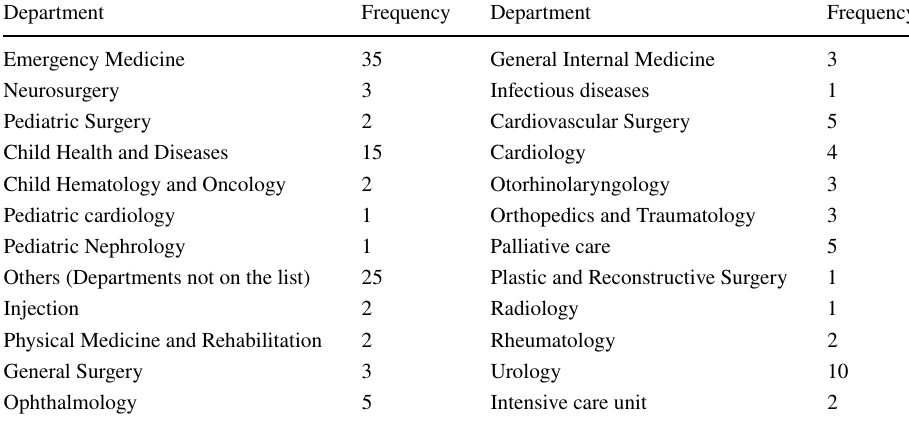
the departments where the participants